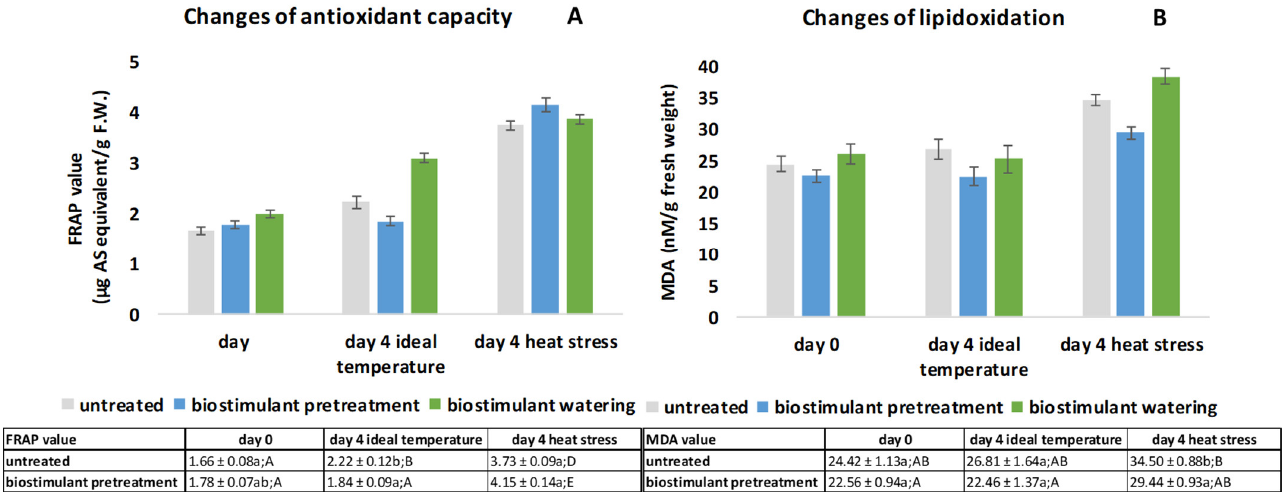
Figure 2. Changes in ( A ) ferric reducing antioxidant capacity and ( B ) lipid oxidation of wheat ( Triticum aestivum L.) seedlings. Mean values ( n = 3) and standard deviations are presented. The same letters represent non-significant differences within each treatment, analyzed with one-way ANOVA ( p ˂ 0.05) with Duncan post hoc test. Upper-case letters refer to the time effect, whereas lower-case